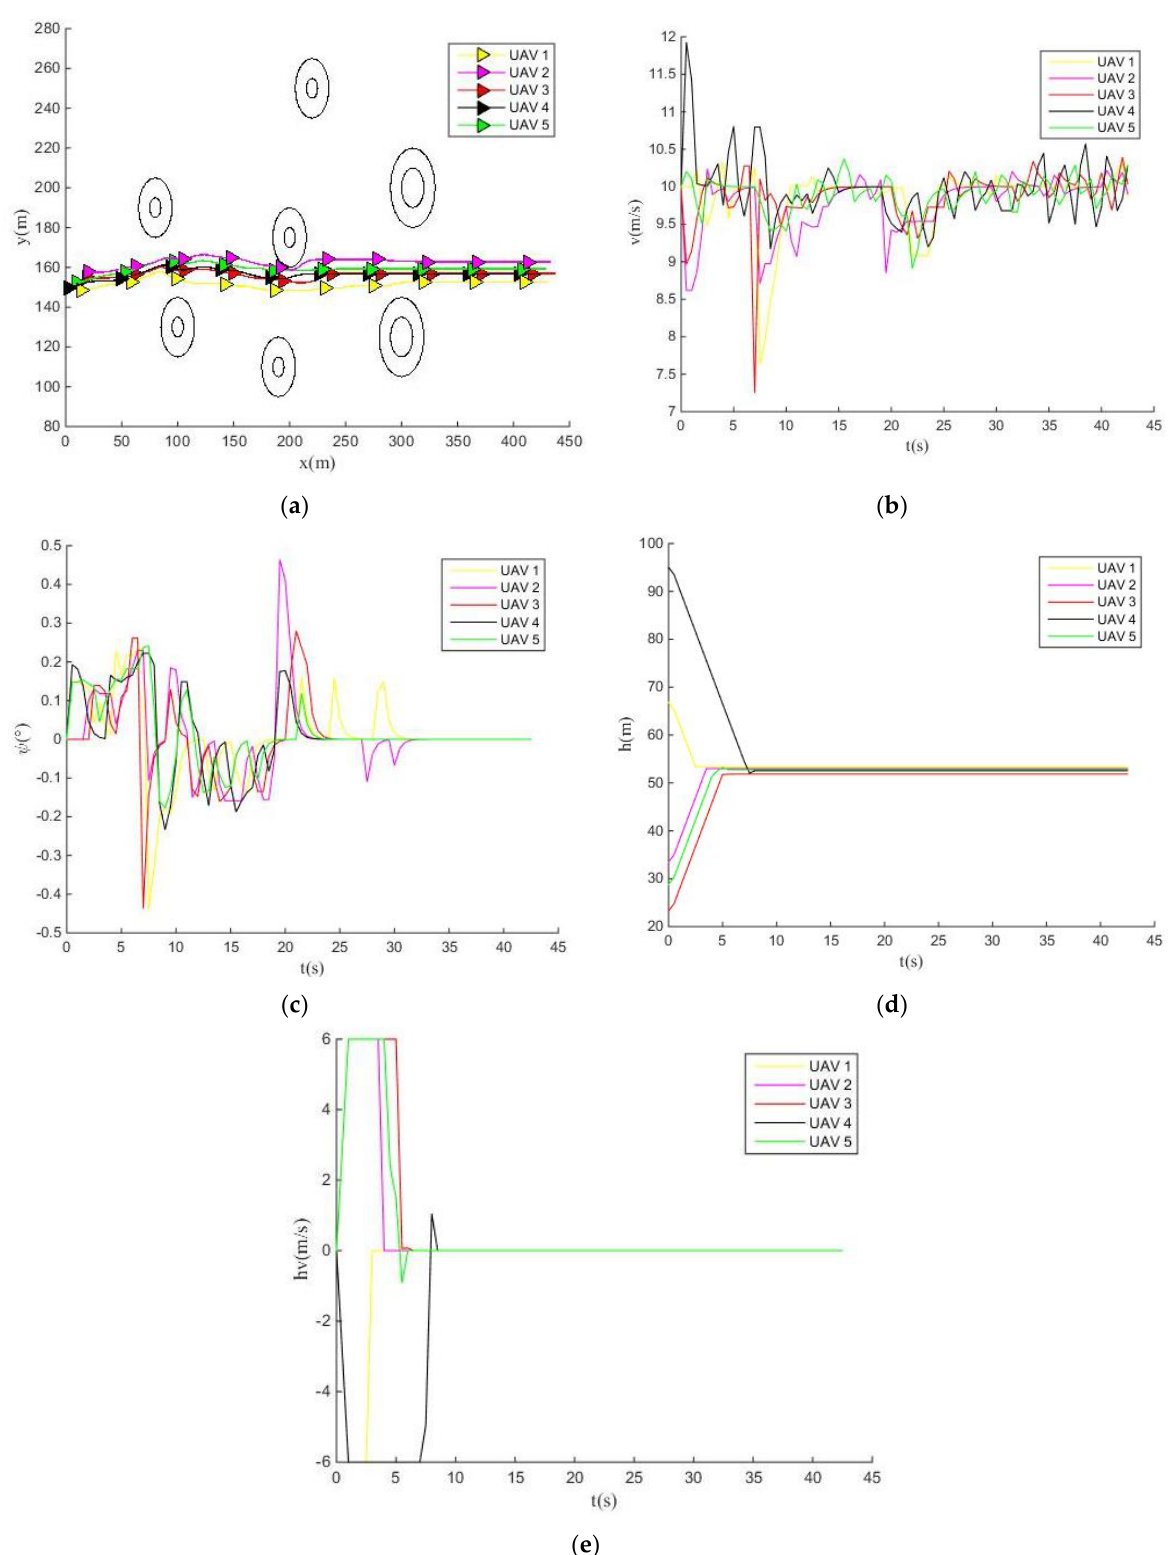
Figure 13. MPIO optimizes the flight change curves of UAVs. ( a ) Obstacle avoidance curve of UAVs; ( b ) Horizontal airspeed change curves of UAVs; ( c ) Yaw angle change curves of UAVs; ( d ) Flight altitude change curves of UAVs; ( e ) Altitude rate change curves of UAVs.